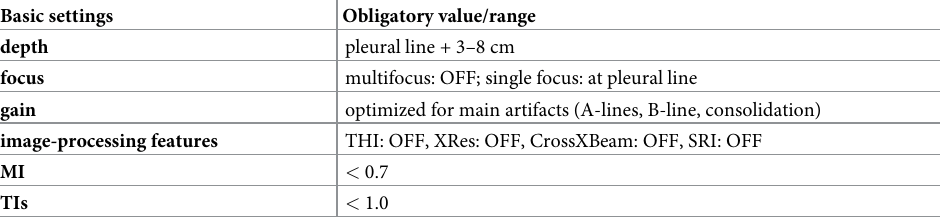
Table 1. Ultrasound settings.